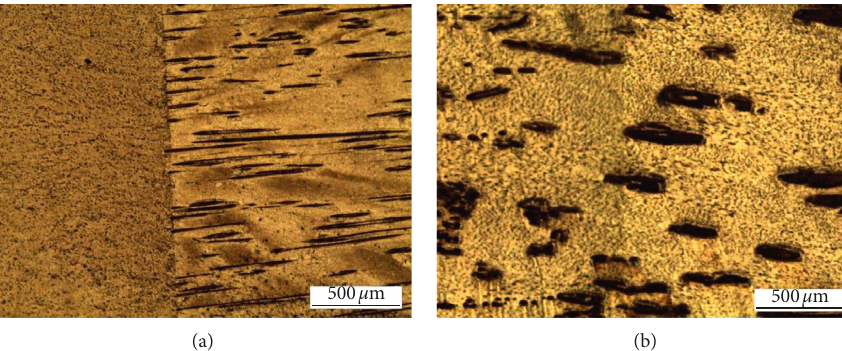
Figure 1: Sn-0.7 wt.% Cu samples directionally solidified and grown from right to left. V � 0.5 µ m/s; G (a) ( η P +Liq)+Liq. interface at the top of growth; (b) solid+( η P +Liq) interface.